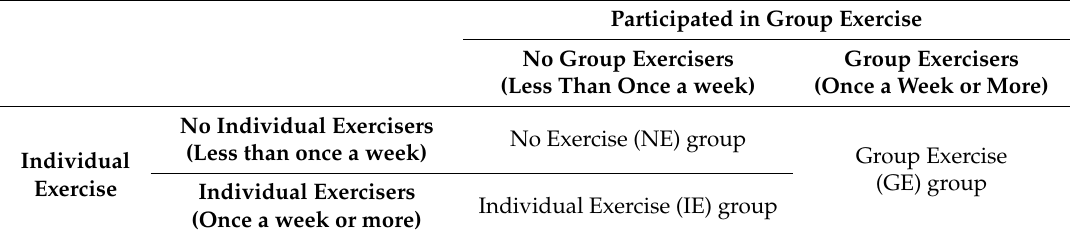
Table 1. Three study groups categorized according to frequency of individual exercise and group exercise